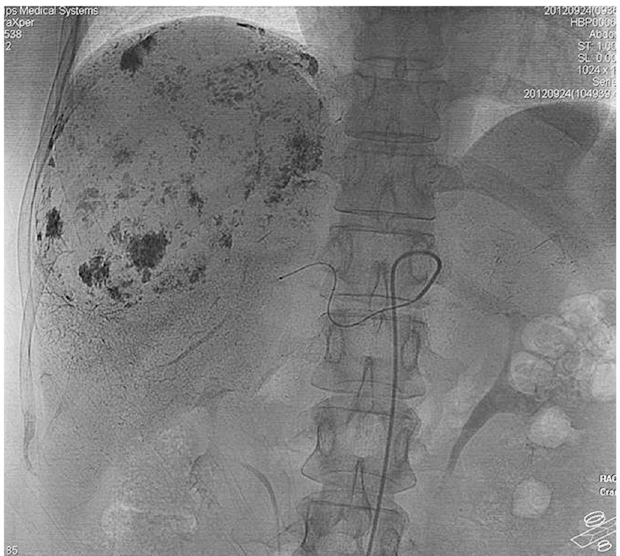
Fig 3. Fluoroscopy. Deposited lipiodol completely surrounding the tumor after injection of the mixture of lipiodol and PYM into the supplying artery.